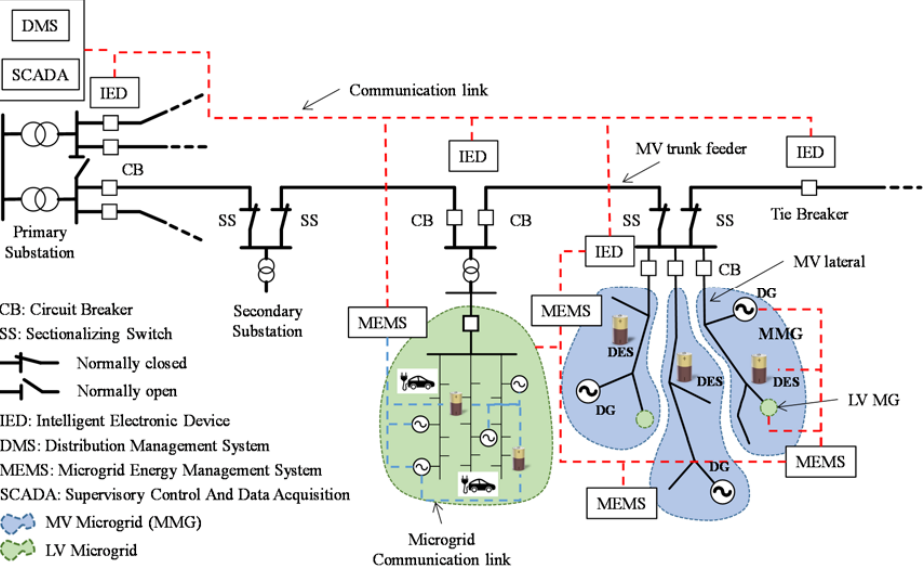
Figure 1. A feasible scheme of a smart distribution network.